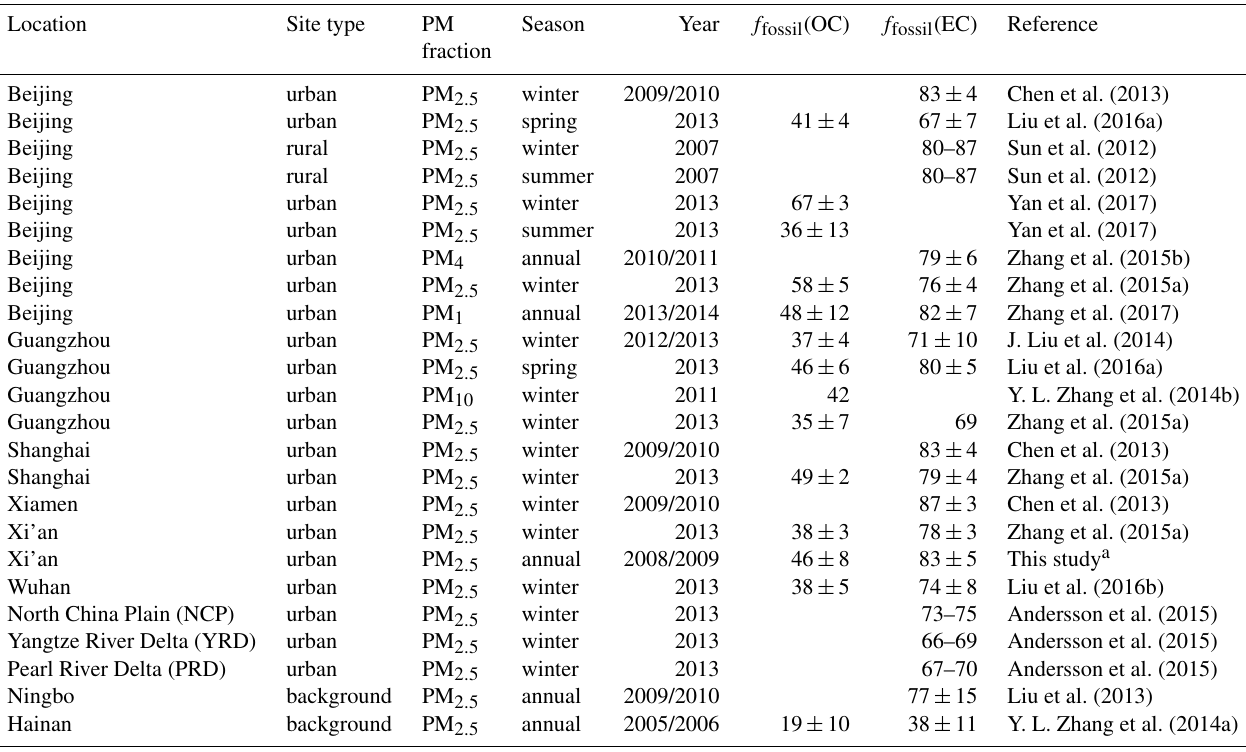
Table 1. Relative fossil source contribution to OC and EC ( f fossil (OC) and f fossil (EC) in percentage) in China.